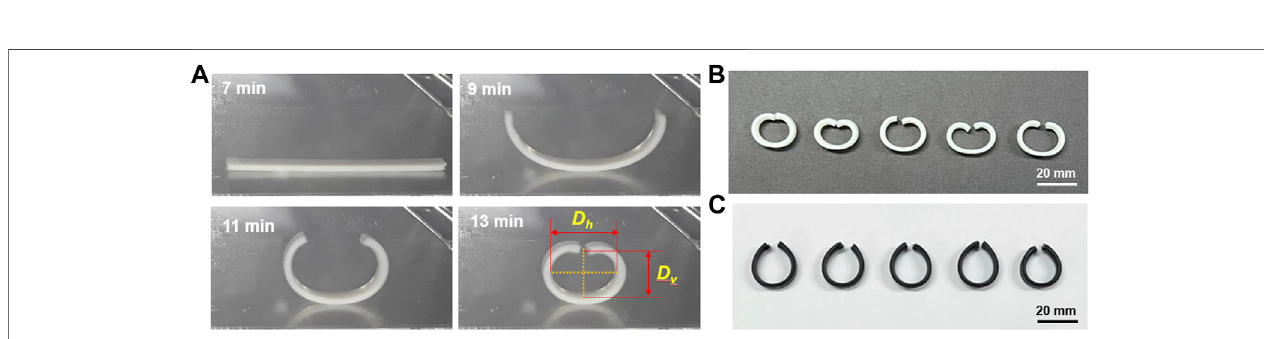
FIGURE 12 | Comparison with the convective heating results (A) Stepwise shape transformation of the rectangular bar (Goo et al., 2020) (B) Transformed specimens after 13 min convective heating (white ABS) (C) Transformed specimens after 60 s IR heating (black ABS).